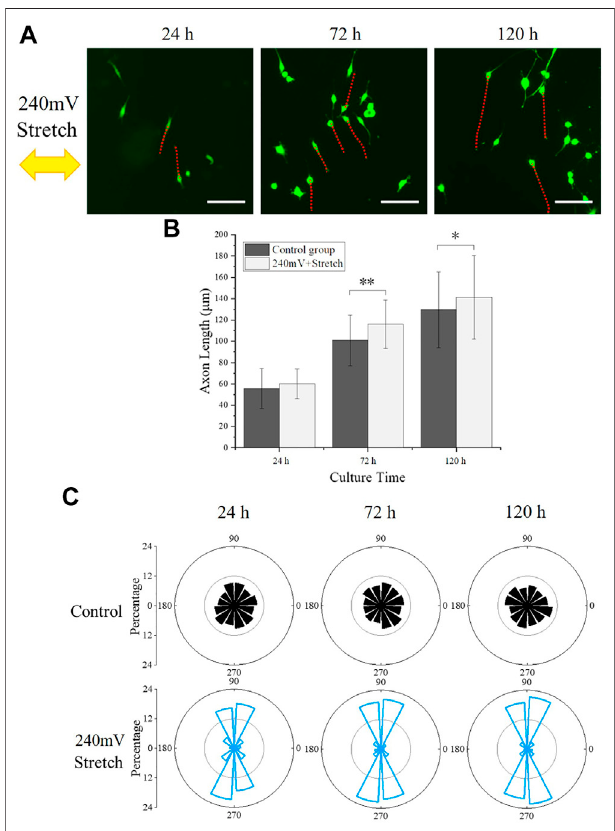
FIGURE 6 | PC12 cell axon orientation analysis. (A) PC12 cells fl uorescence images under electromechanical stimulation, with red dotted lines indicating the axon outgrowth and the yellow arrow representing the stretching direction. Scale bar: 100 μ m. (B) Statistical results of axon length. The signi fi cant difference between groups is indicated ( p , p < 0.05; pp , p < 0.01; n > 150 cells). (C) Statistical angular distribution of axon orientation based on the fl uorescence